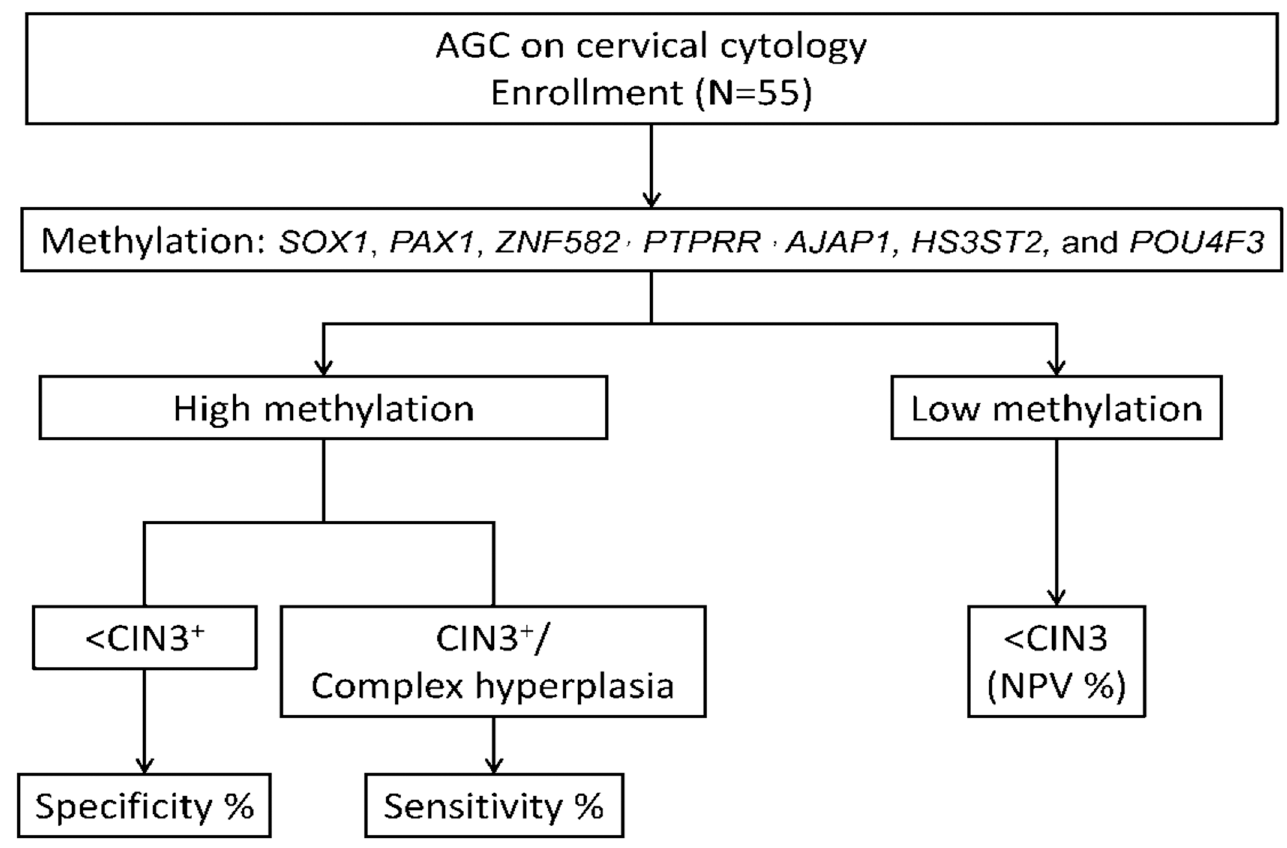
Fig 1. Study flowchart: All women were invited to participate in diagnosis of AGC with a methylation biomarker study. Physician-directed sampling was performed with a cytobrush (CooperSurgical, Inc.). Patients with Pap smear of AGC underwent colposcopy and cervical biopsy, endometrial sampling, or conization in accordance with treatment guidelines. CIN III/CIS and complex hyperplasia of the endometrium were taken as cutoff criteria for QMS-PCR of seven genes. The receiver operating characteristic (ROC) curve was used to select the optimal cutoff value for the methylation level of each gene. Methylation levels that were higher than the threshold were classified as “ high methylation ” , whereas those that were lower than the threshold were recorded as “ low methylation ”